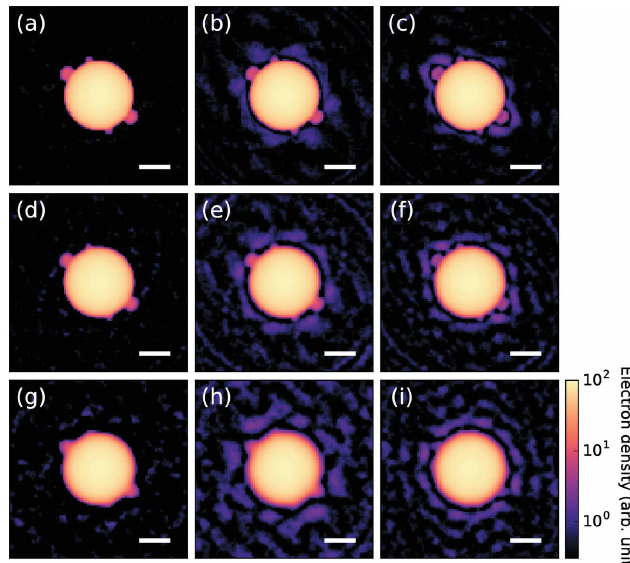
Figure 4 Electron density reconstructed from the simulation data using the present method. Each figure represents the reconstructed structure obtained from the corresponding diffraction pattern in Fig. 3. The scale bars are 100 nm.